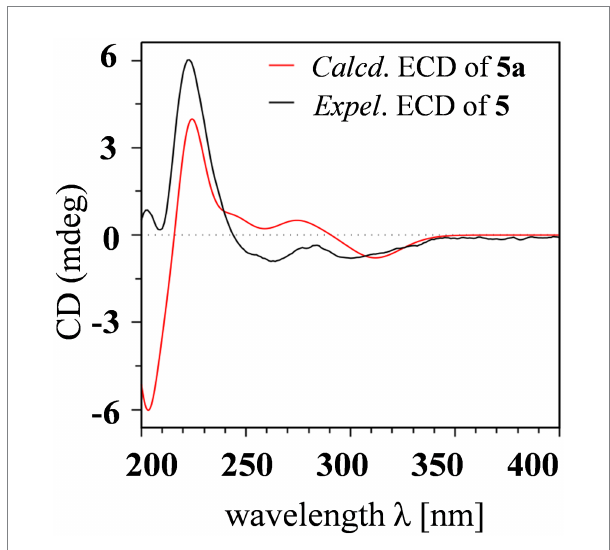
FIGURE 6 Experimental ECD spectrum of 5 and calculated ECD spectrum of 5a